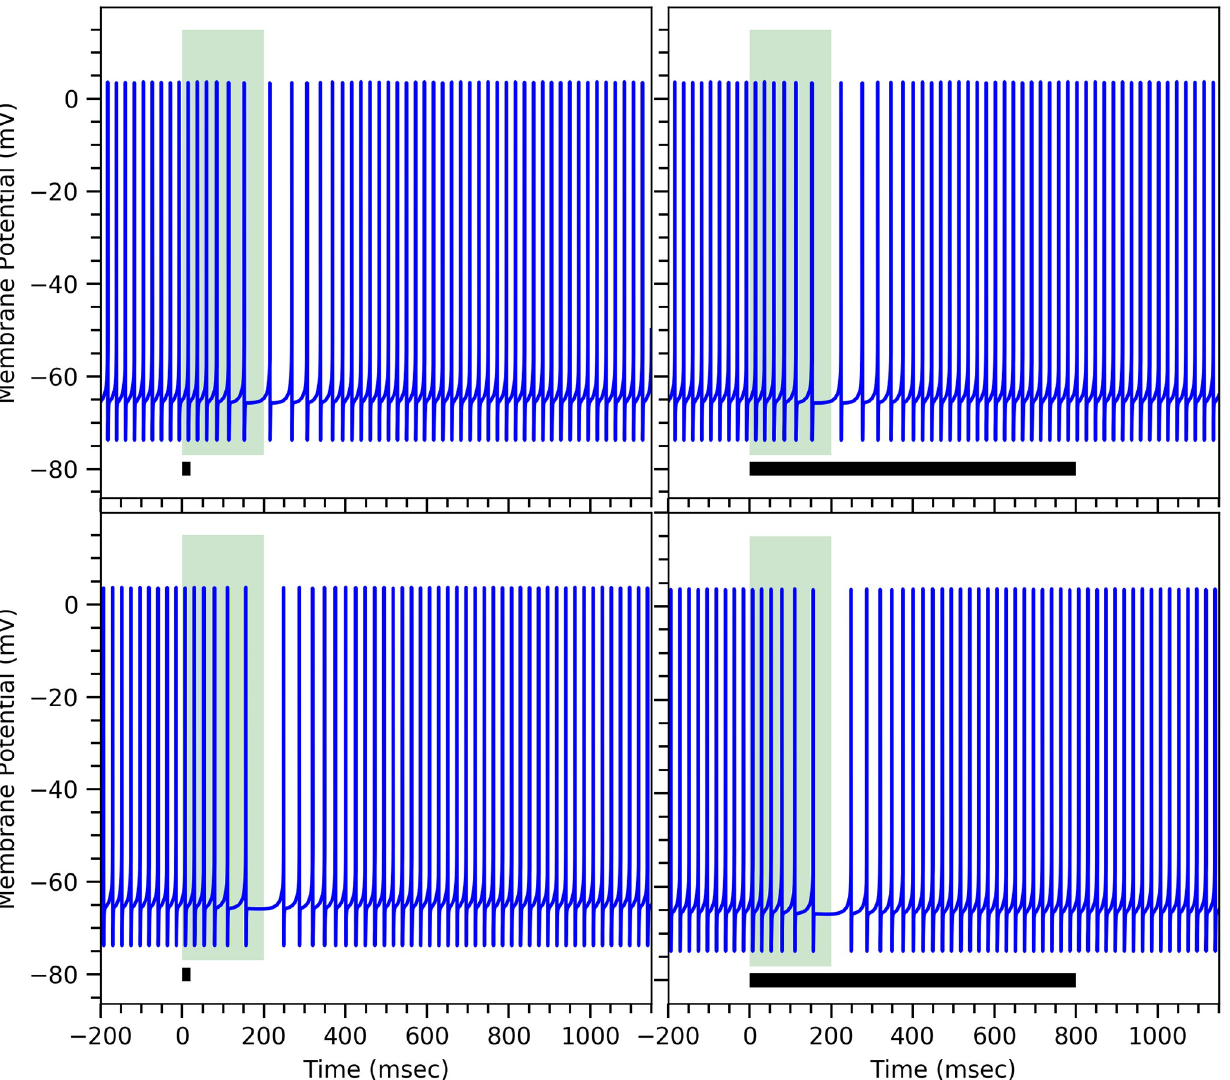
Fig 6. Conditional response in both models is independent of conditional stimulus duration. Membrane potential of the Purkinje cell during conditional response for ISI = 200msec obtained using our minimal model (top panels) and our comprehensive model (bottom panels). The width of the light green vertical bar corresponds to the duration of the ISI and the black bar at the bottom signifies the conditional stimulus duration, which is short in the left panels and long in the right panels. Parameters for both models are the same as in (Fig 3).